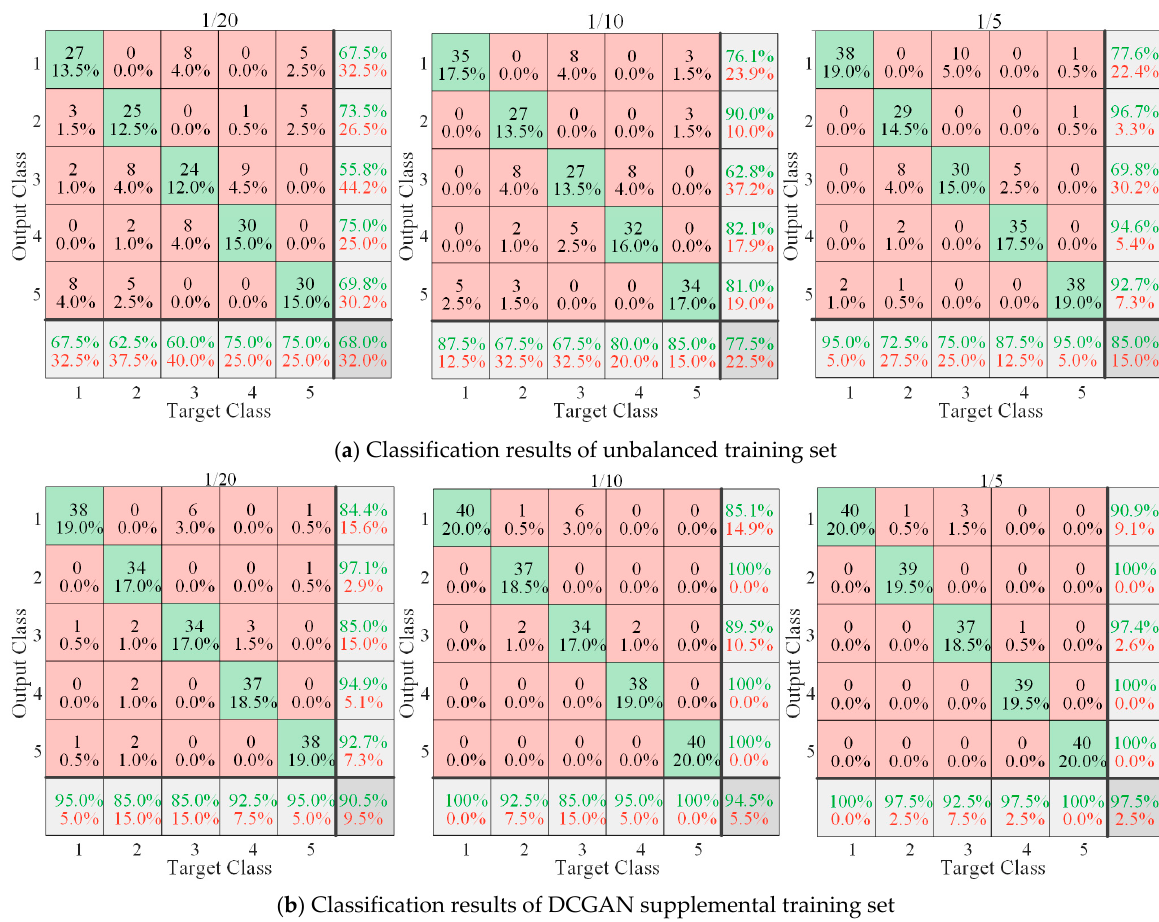
Figure 14. Confusion matrix for different diagnosis models.